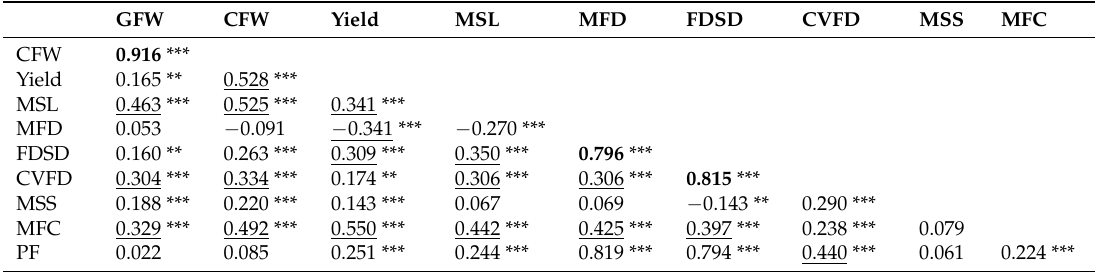
Table 1. Pearson correlation coefficients between various wool traits ( n = 384 Merino × Southdown-cross sheep). GFW CFW Yield MSL MFD FDSD CVFD 0.304 *** MFC Correlations with | r | > 0.7 are in bold, and those with 0.3 <| r | ≤ 0.7 are underlined. ** p < 0.01. *** p < 0.001. GFW: Greasy fleece weight; CFW: clean fleece weight; Yield: wool yield; MSL: mean staple length; MFD: mean fibre diameter; FDSD: fibre diameter standard deviation; CVFD: coefficient of variation of fibre diameter; MSS: mean staple strength; MFC: mean fibre curvature.